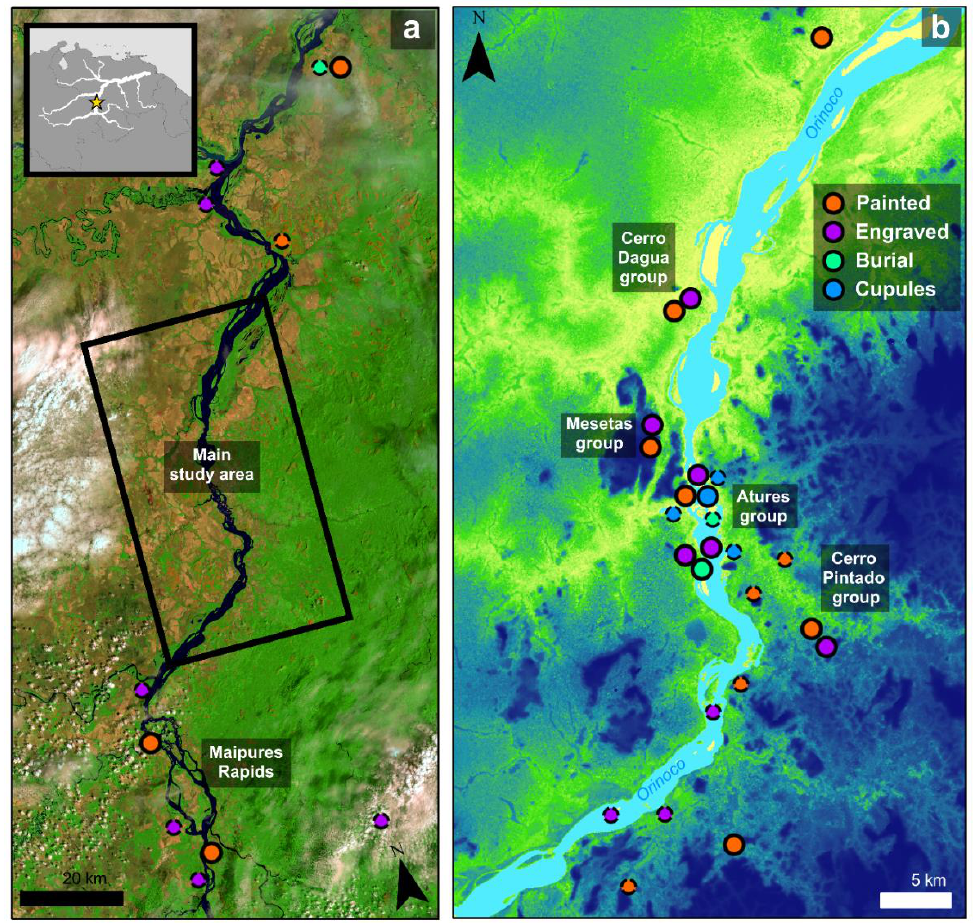
Figure 1. Major clusters of rock art, mortuary sites, and cupules in the Middle Orinoco ( a ) and Á tures Rapids ( b ) reported on in this paper. Locations are approximate and may represent more than one site. Broken outlines indicate reported sites with incomplete or no data.